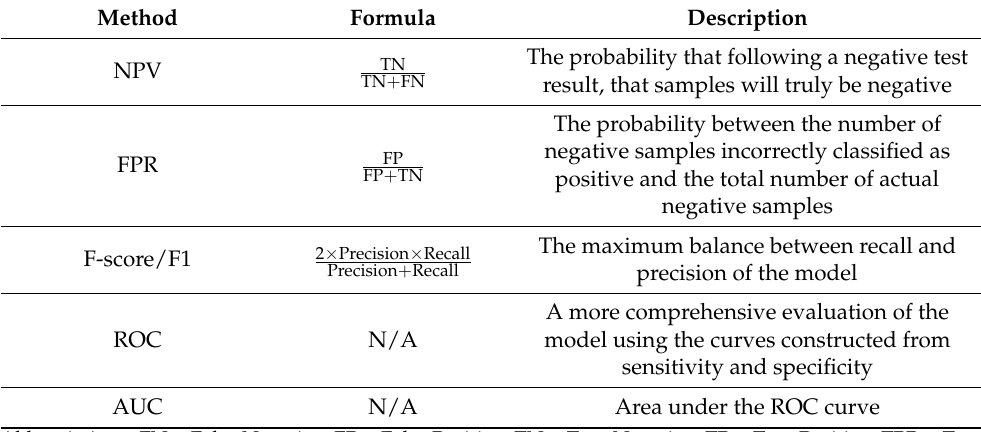
Table 1. Cont. Method Formula Description The probability that following a negative test NPV TN TN + FN result, that samples will truly be negative The probability between the number of negative samples incorrectly classified as FPR FP FP + TN positive and the total number of actual negative samples The maximum balance between recall and F-score/F1 2 × Precision × Recall Precision + Recall precision of the model A more comprehensive evaluation of the ROC N/A model using the curves constructed from sensitivity and specificity AUC N/A Area under the ROC